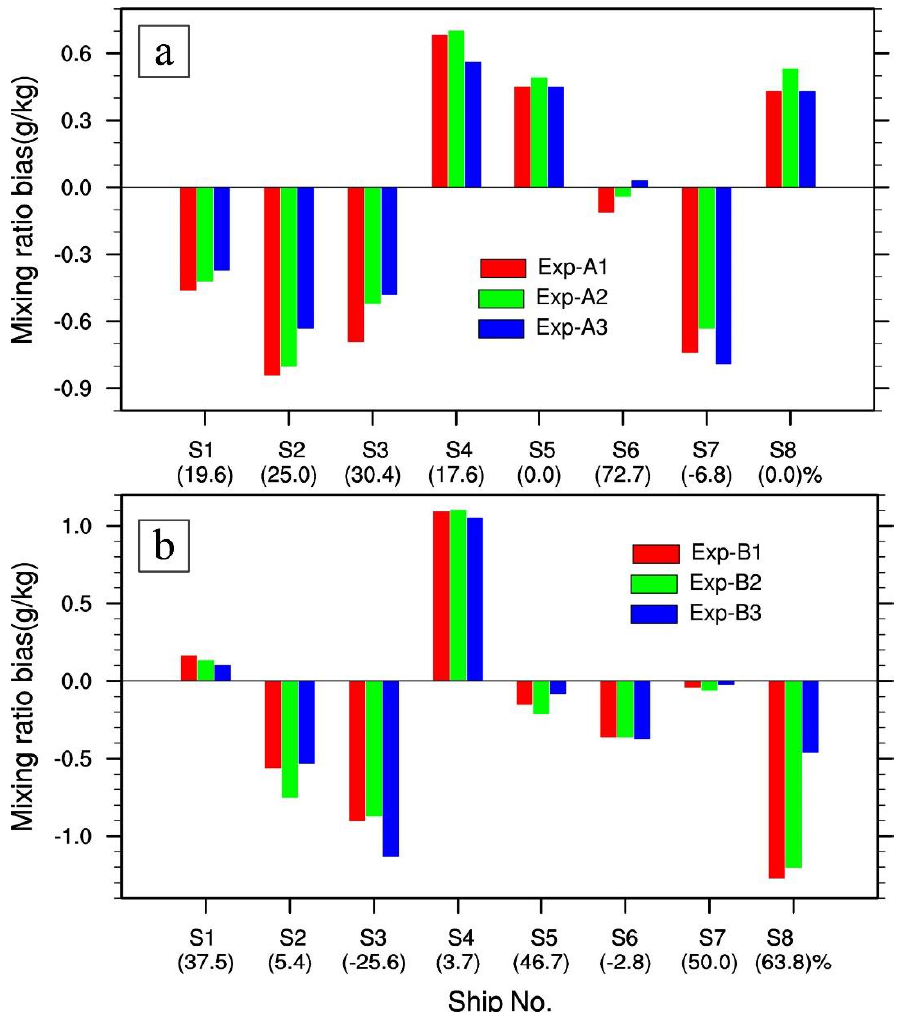
Figure 8. Biases between the forecasted and observed mixing ratio for the cases ( a ) C-09 and ( b ) C-14. Numbers in parentheses are the mixing ratios of ship measurements. The improvements (%) of Exp-A3 relative to Exp-A1 are in parentheses below the S# (identified mark of ship) along horizontal coordinates, as well as Exp-B3 relative to Exp-B1.